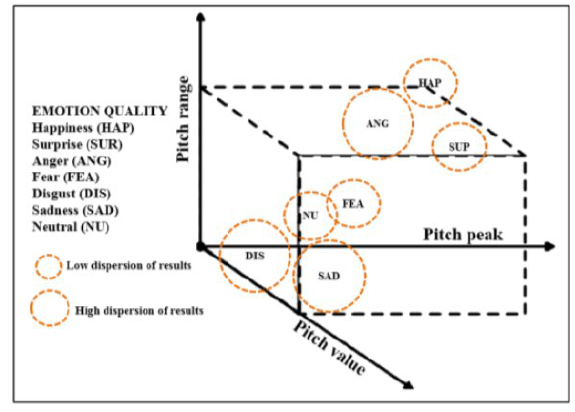
Fig. 21. The location of the emotions in the three-dimensional graph with axes: pitch (range, peak and value).